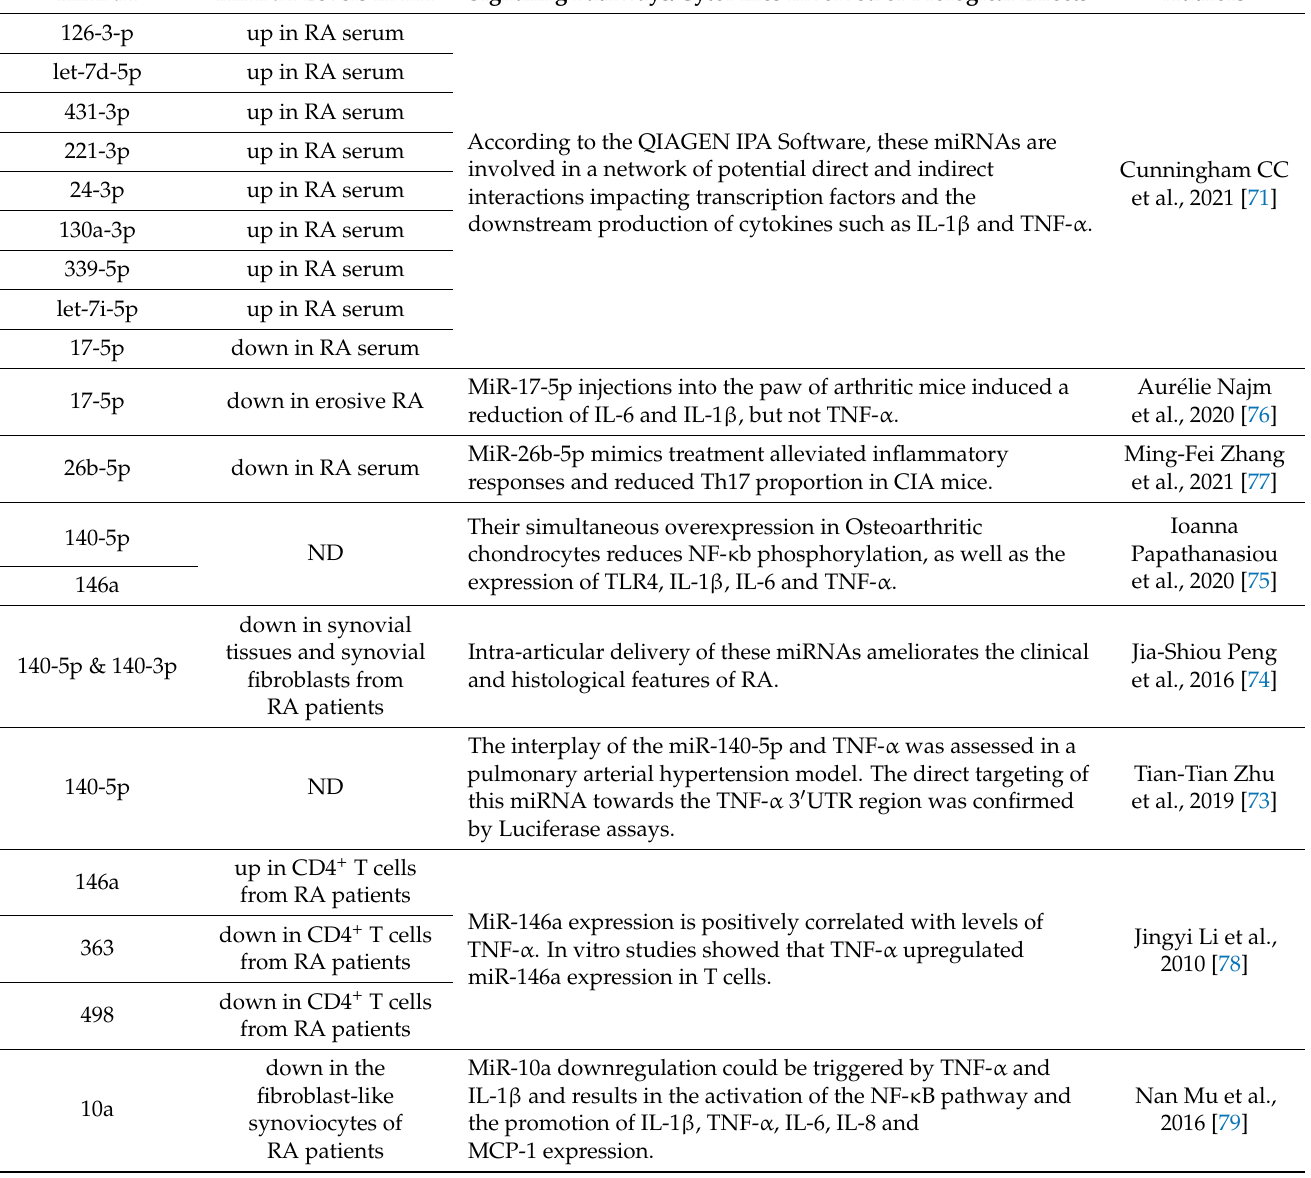
Table 1. Non-exhaustive list of miRNAs related to RA pathogenesis and their biological effects on the pro-inflammatory cytokines and factors IL-1 β and TNF- α . ND: no